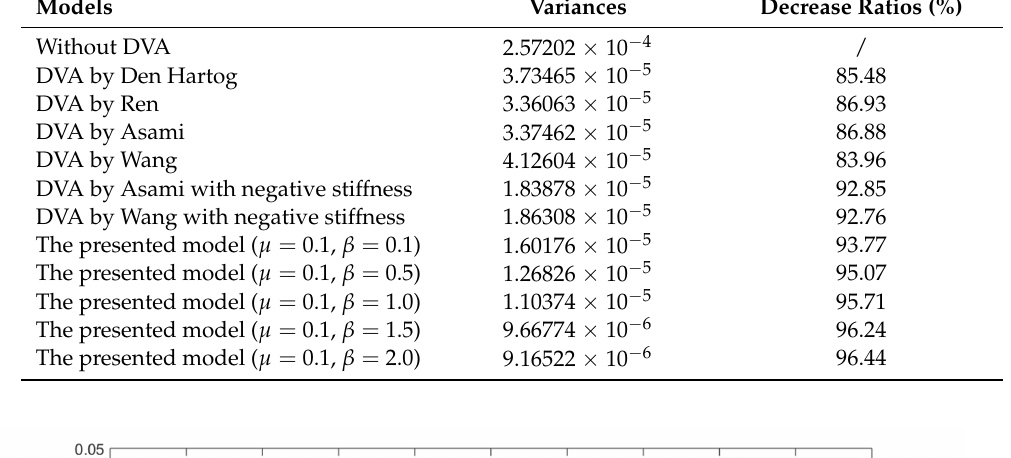
Table 5. The variances and decreasing ratios of the displacements in the primary system.